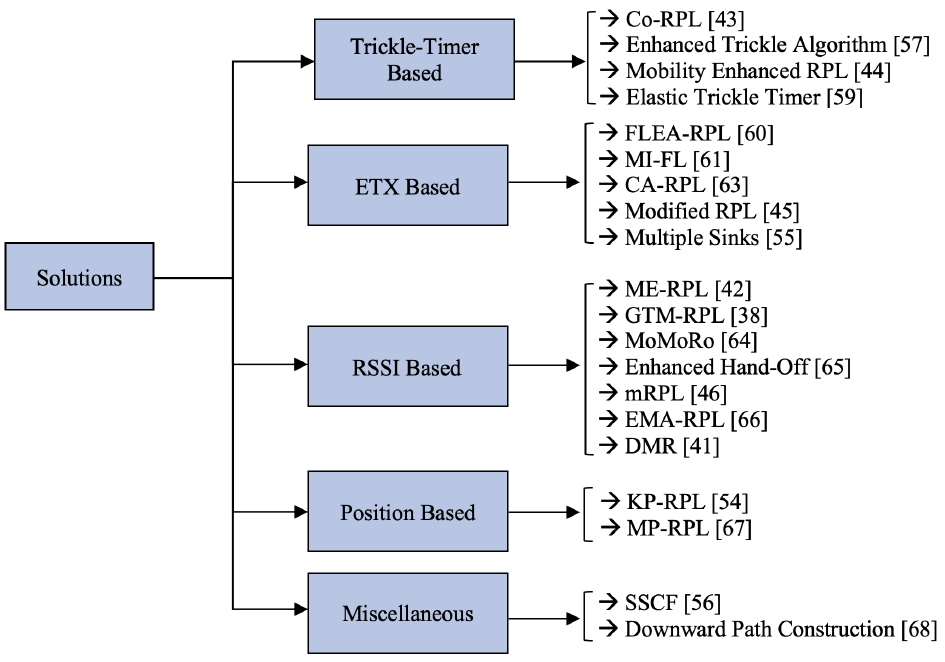
Figure 3. Classification of